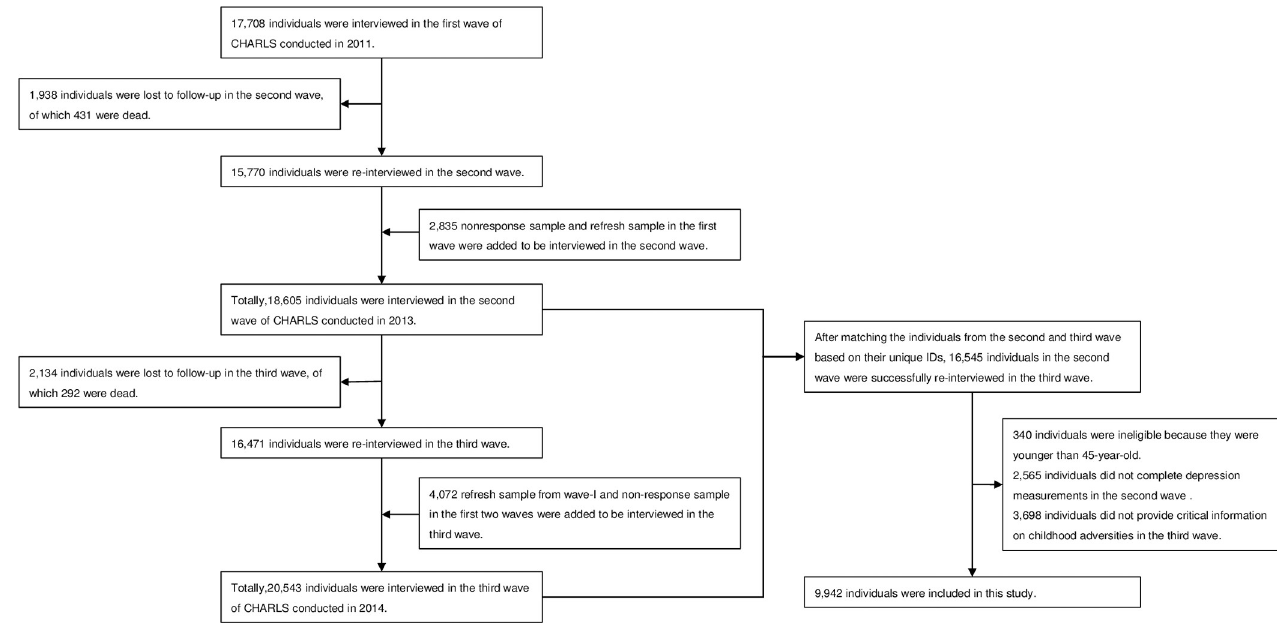
Fig 2. Flow chart of participants in the